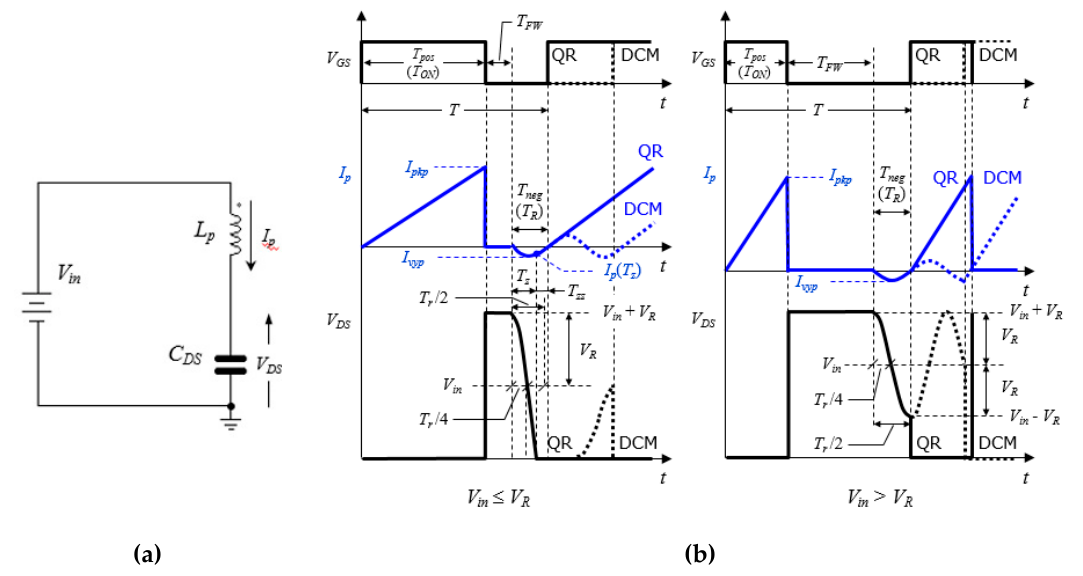
Figure 12. ( a ) Simplified equivalent circuit during T neg , ( b ) key waveforms in QR-mode and DCM operations.